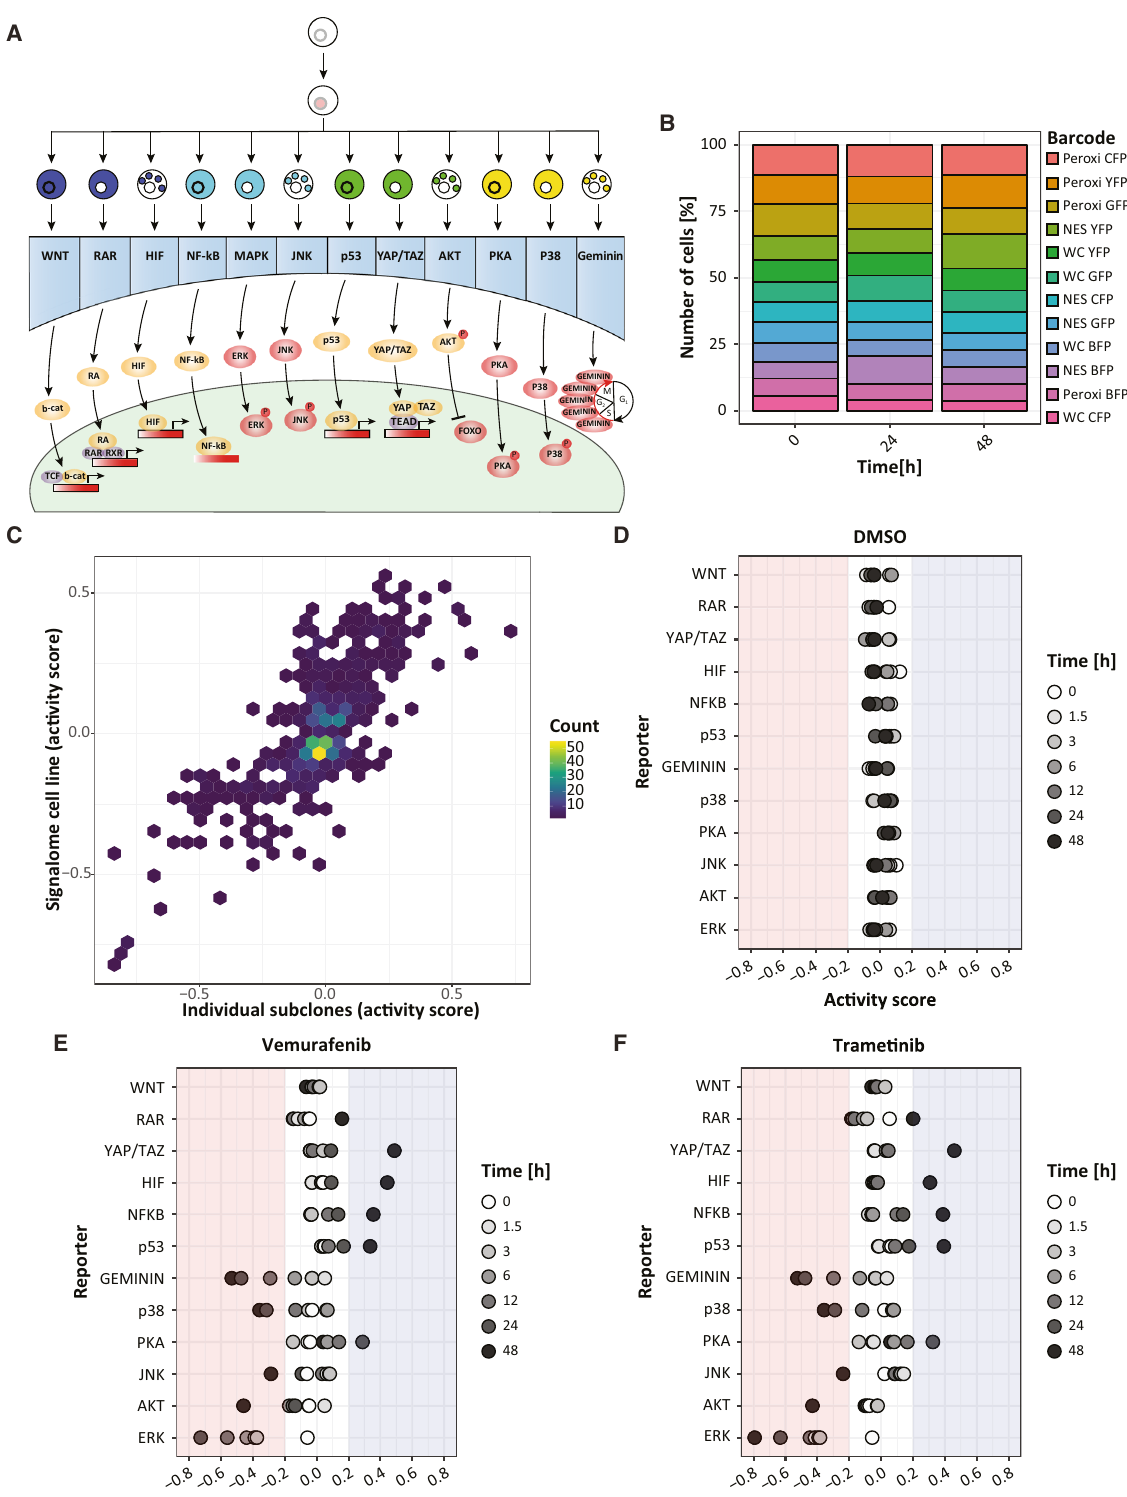
or B (intracluster correlations) and negative correlations when comparing pathways from cluster A to pathways from cluster B (intercluster correlations). For simplicity, we will refer to these two clusters as the p38 signaling state (cluster A) and the p53- signaling state (Cluster B) (Fig. 3A). Chemical perturbations can generate correlated in fl uences by simultaneously affecting more than one target. Such